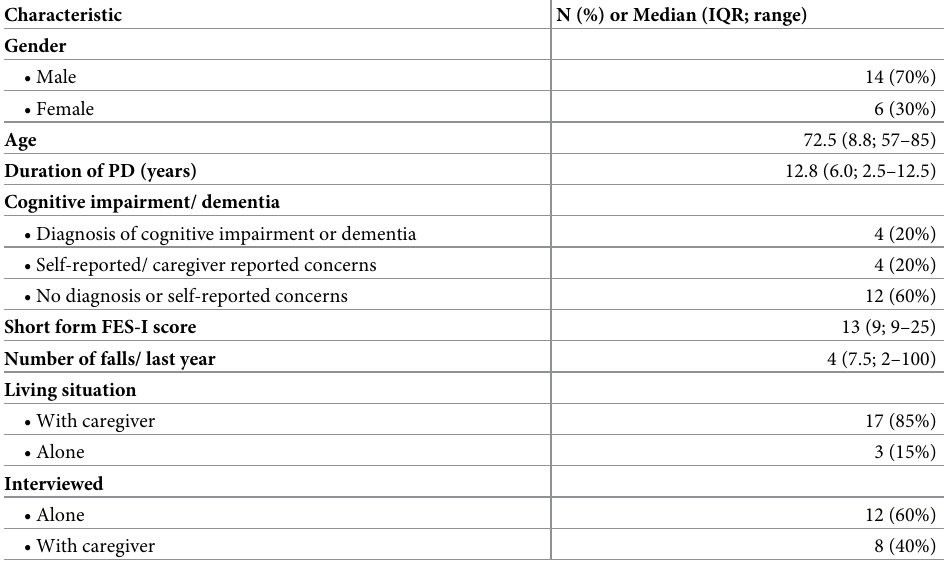
Table 1. Demographic details of people with Parkinson’s